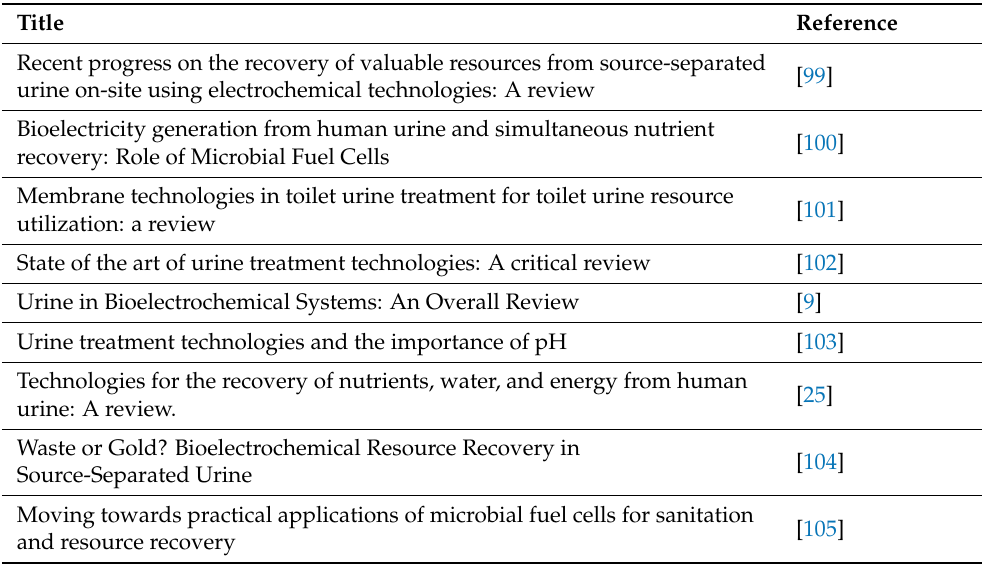
Table 4. Recently published reviews related to human urine treatment for byproduct